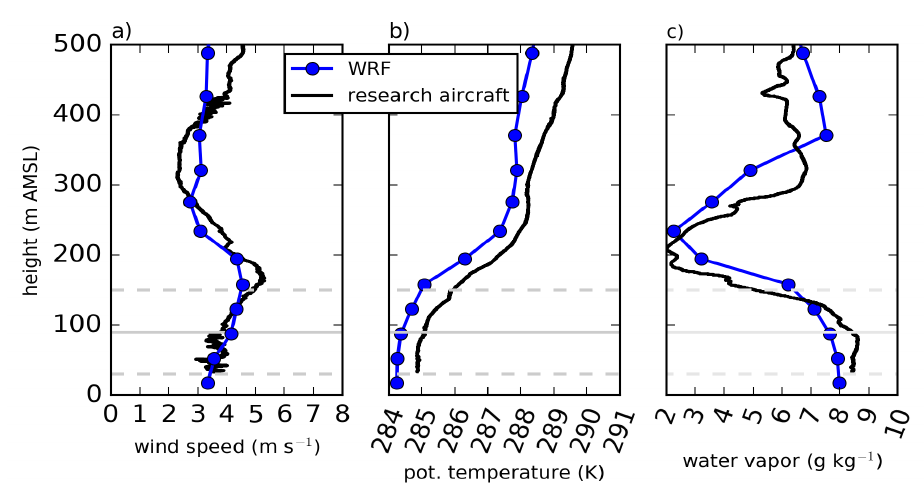
Figure 12. WRF simulations and airborne observations on 2 June 2017 at 09:15 showing: ( a ) vertical profile wind speed, ( b ) potential temperature, and ( c ) water vapour mixing ratio.